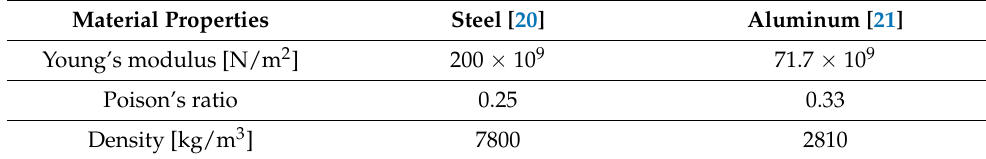
Table 2. Properties of the materials used for simulation.